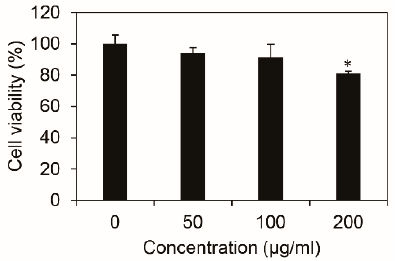
Figure 1. Effects of Inonotus obliquus extract on the cell cytotoxicity of B16F10 mouse melanoma cells. There is no significant difference between the control and the Inonotus obliquus extract-treated cells. The cell viability is shown as a percentage of the control at the stated concentration. *: cytotoxicity at the stated concentration. The data values were obtained from the average of three independent experiments ±SD (standard deviation).